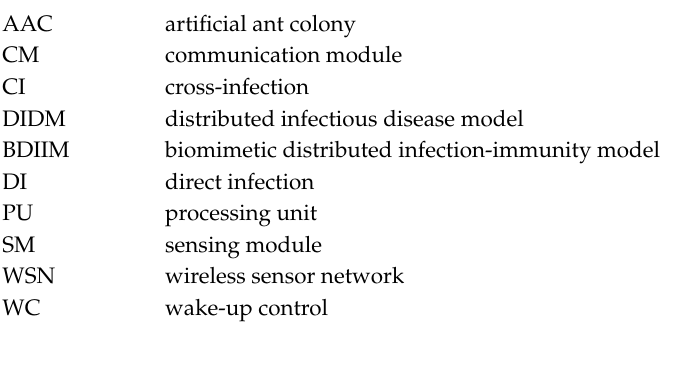
Figure 14. Energy cost and target position estimation in WC performance: ( a ) Total energy cost. ( b ) Target position estimation error. ( — : BDIIM; -- : DIDM). Table 8. Energy cost and position estimation error of the nodes in WC.